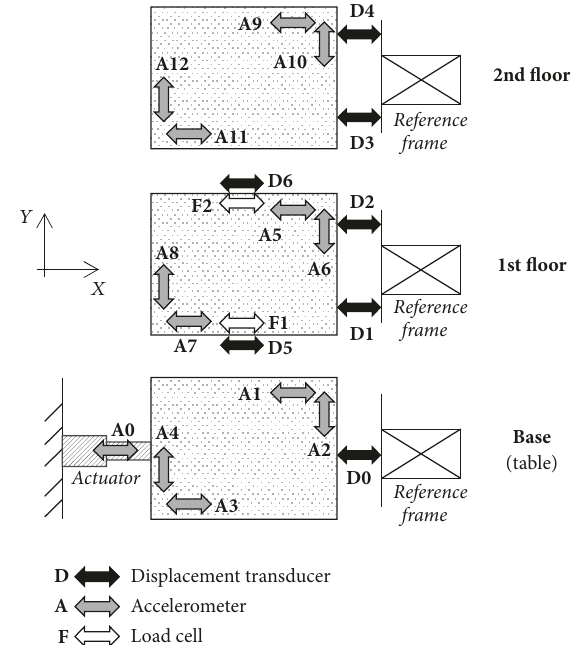
Figure 5: Plan view of base, 1st floor, and 2nd floor: position of sensors. D5 and D6 measured displacement demand in MR dampers. F1 and F2 measured the reaction’s force of these